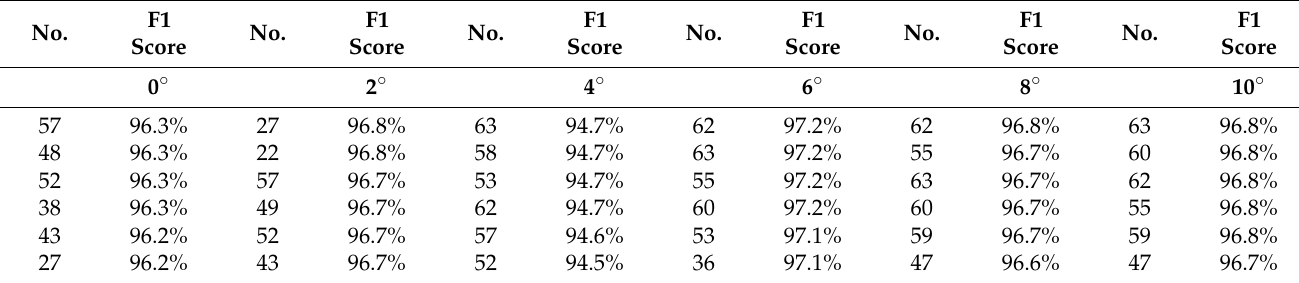
Table 11. Top six multifeature combinations for overall accuracies of SW at small incidence